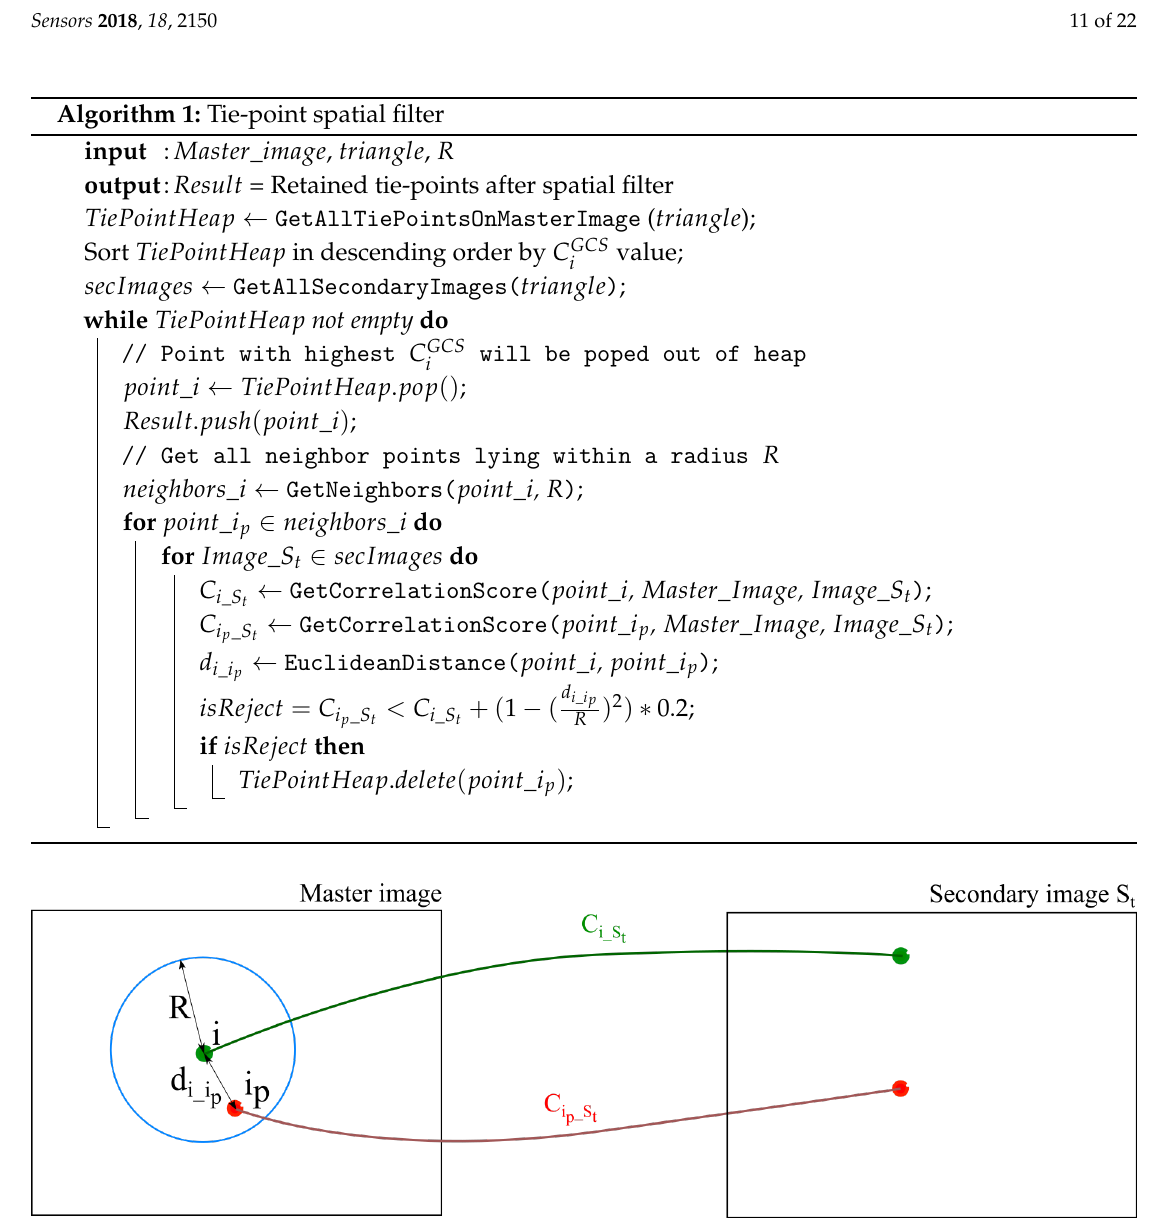
is the correlation score between point i on t